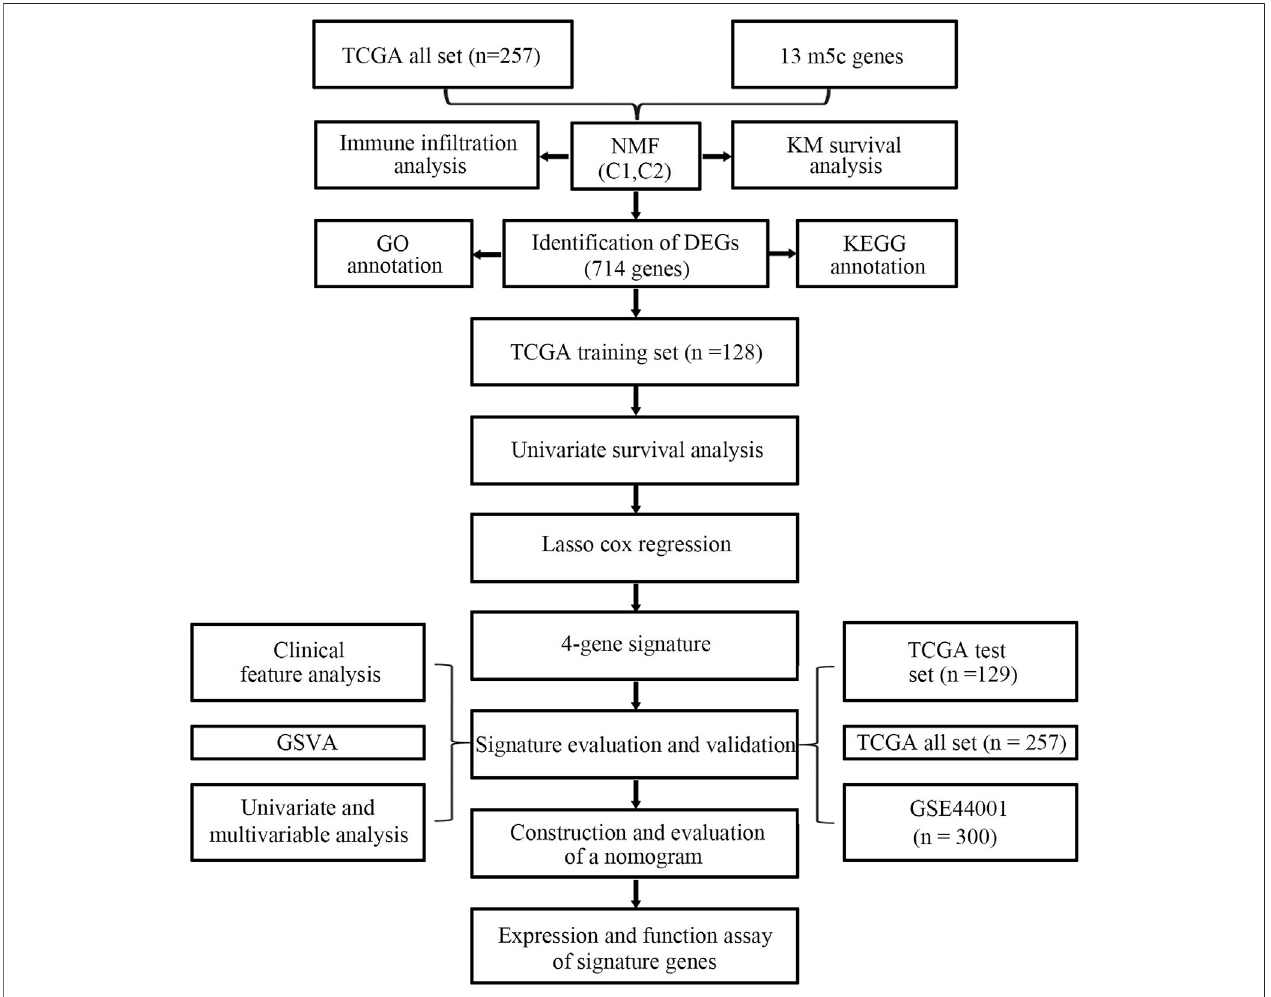
FIGURE 1 | Flow chart for the